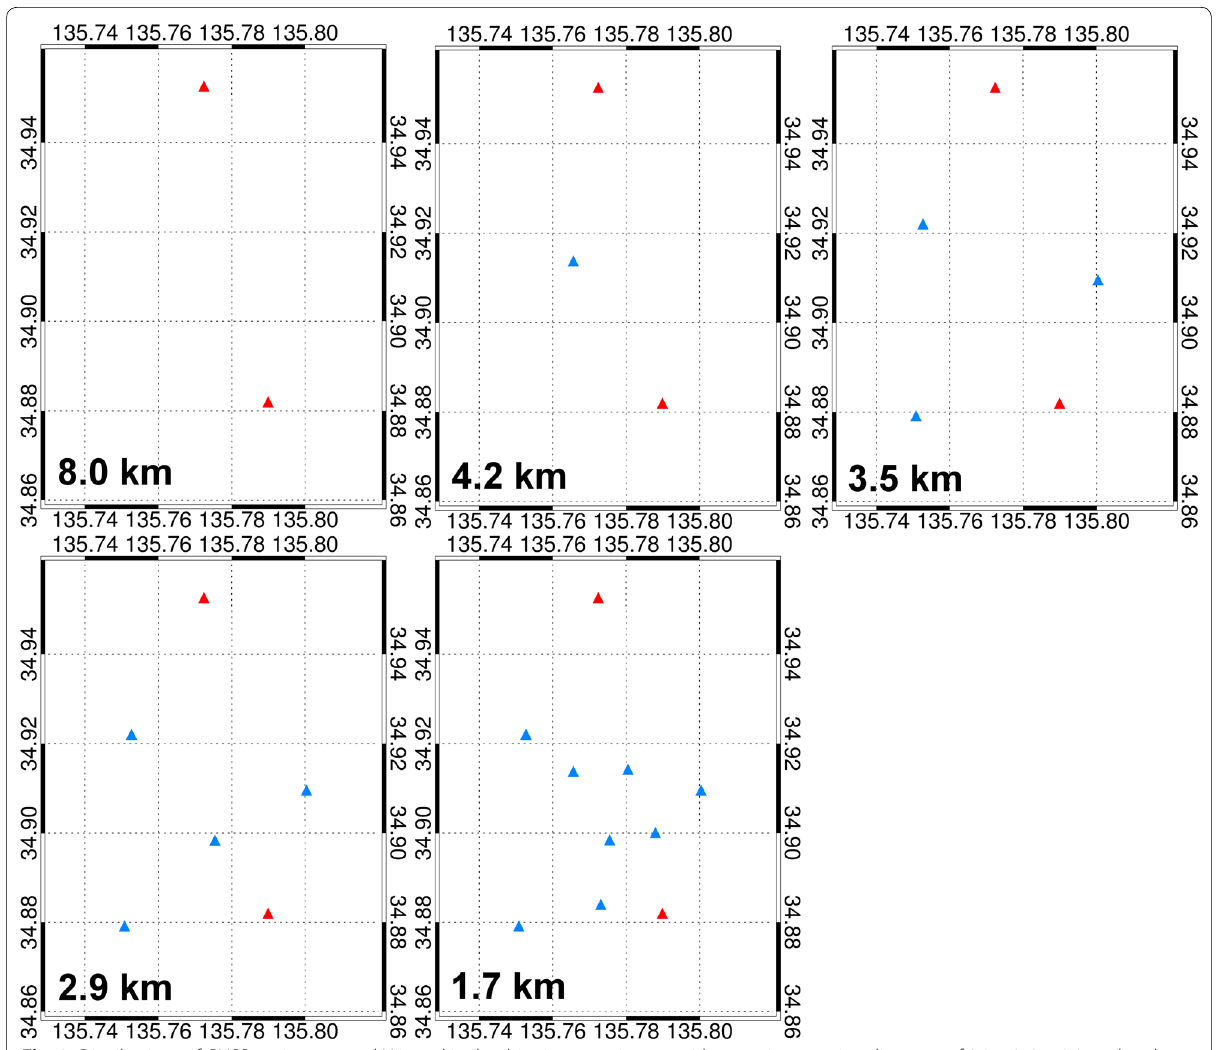
Fig. 9 Distributions of GNSS stations around Uji used in the thinning experiments with mean inter-station distances of 8.0, 4.2, 3.5, 2.9, and 1.7 km. Blue- and red-colored triangles indicate stations of the Uji network and GEONET,